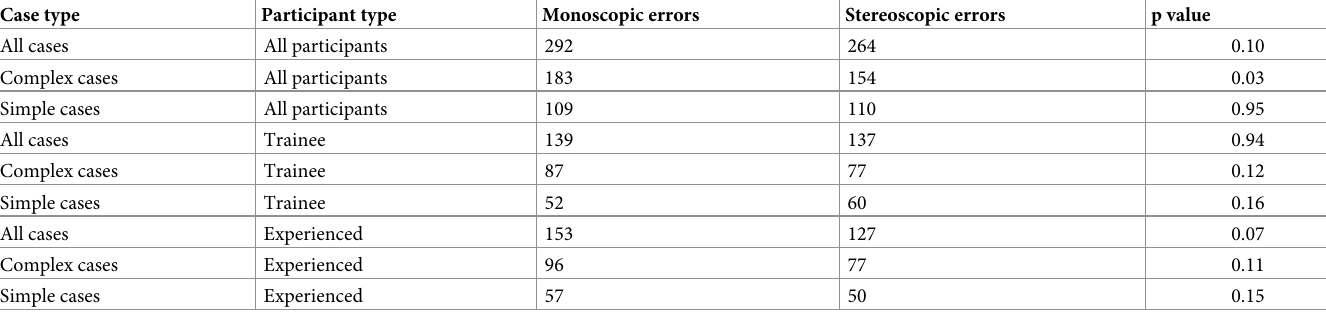
Table 3. Summary of type 2 errors by type of case (all cases, complex, simple), participant type (all, trainee, experienced), and p